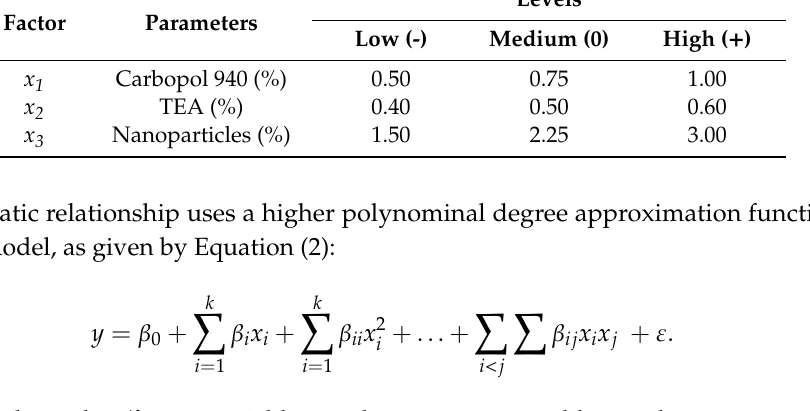
Table 1. Design level of Arabica co ff ee ground nanoparticles gel formulation with three factors ( x ) and three levels.